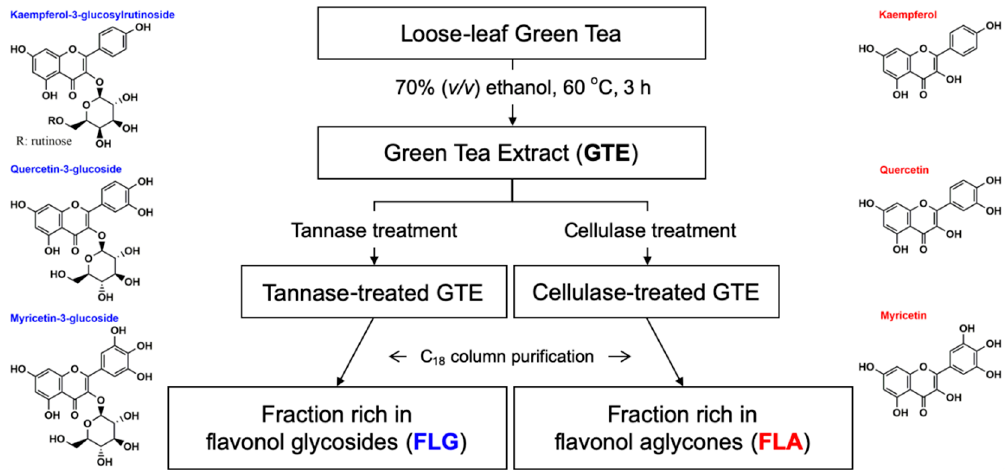
Figure 1. Diagram of the extraction and the purification processes with enzymatic treatment to obtain fractions rich in flavonol glycosides (FLG) and flavonol aglycones (FLA). The chemical names in blue and red indicate flavonol glycosides and flavonol aglycones, respectively.